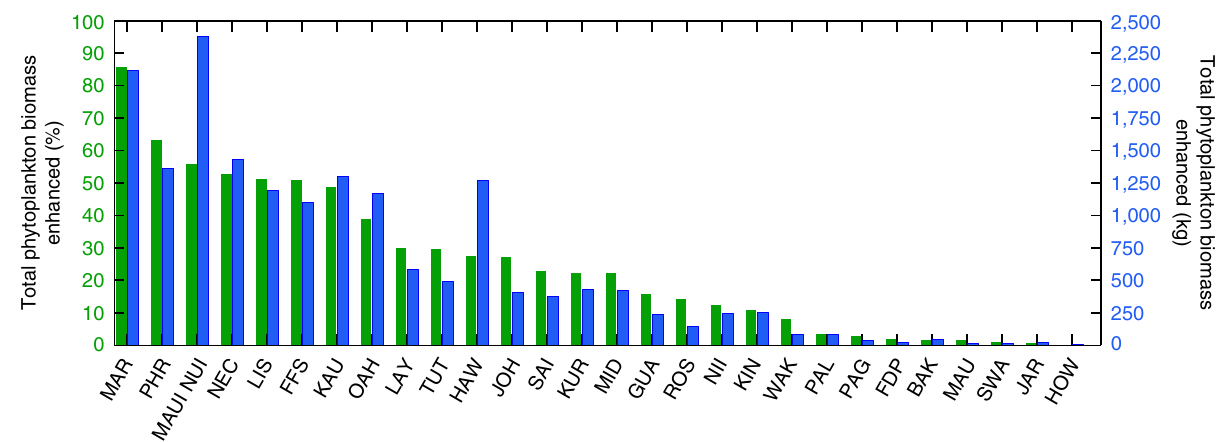
Figure 5 | Total phytoplankton biomass enhanced near Pacific island- and atoll-reef ecosystems. Bars represent the total increase in long-term phytoplankton biomass at each location over offshore, oceanic phytoplankton biomass. Values are shown in percentage (green bars; left y -axis) and kg (blue bars; right y -axis), oriented in decreasing percent biomass from left to right. All locations had significant linear fits ( P o